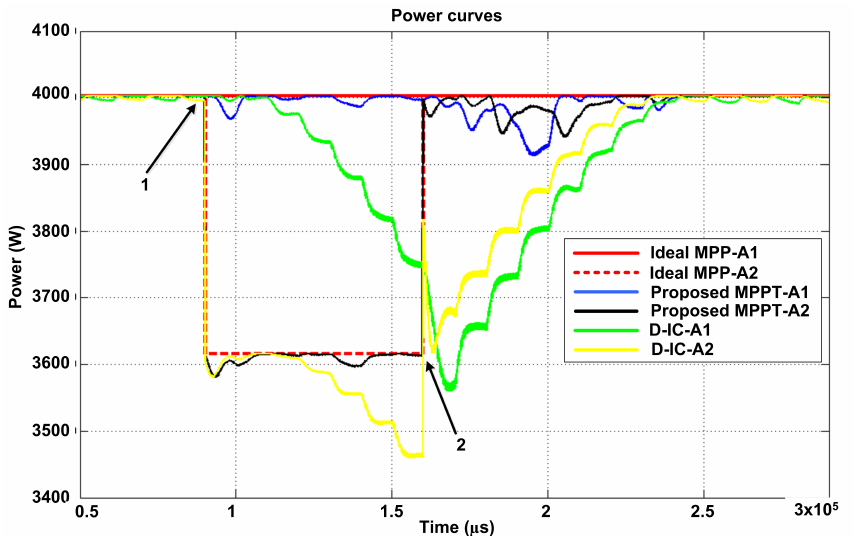
Figure 15. Partial Shading Case 1: Response of algorithms.